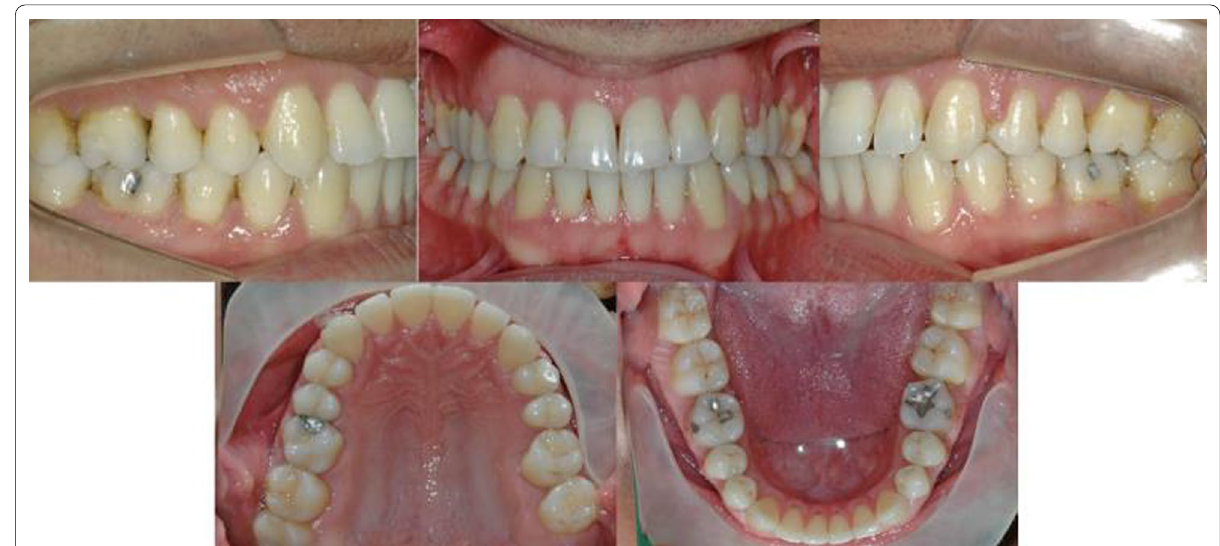
Fig. 2 Posttreatment photographs of an adult patient with one permanent first molar loss who as treated with space